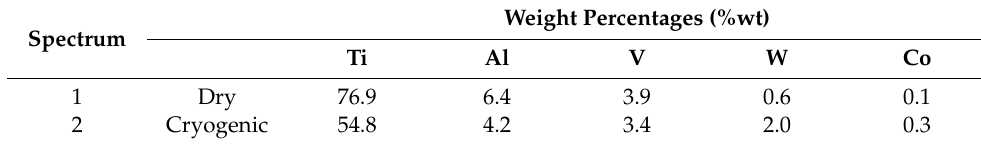
Table 3. EDS weight percentages at different spectra after orthogonal turning.